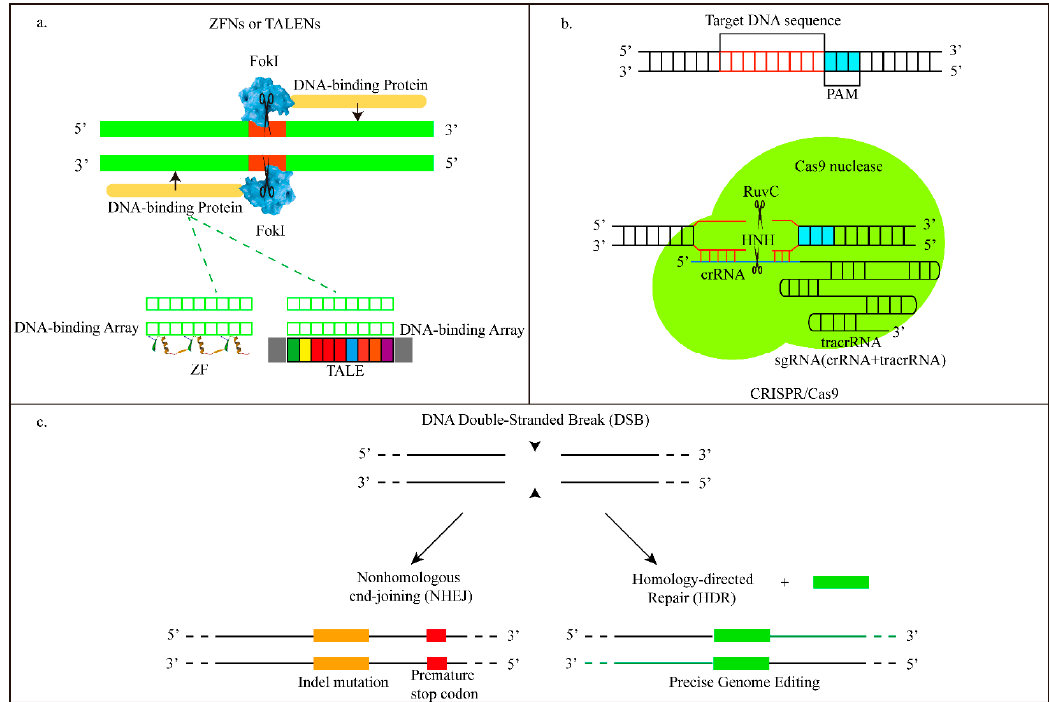
Figure 1. Endogenous DNA repair and three genome editing tools. ( a ) Zinc finger (ZF) and transcription activator-like effector (TALEs) proteins are DNA-binding domains which can be modularly combined to bind targeted sequences. ZF and TALE domains can separately recognize three and one bp of DNA. These site-specific nucleases are the fusion of DNA-binding domains and Fok I endonucleases; ( b ) Cas9 nucleases in the clustered regularly-interspaced short palindromic repeat-associated nuclease Cas9 (CRISPR/Cas9) system target specific DNA sequences with the guide aid of sgRNA, then directly achieve base-pairing with target sequences. The binding of the Proto-spacer adjacent motifs (PAM, blue) downstream of target sites aids to directing Cas9-mediated double-stranded break (DSB); and ( c ) DNA DSBs can be typically repaired via non-homologous end-joining (NHEJ) or homology-directed repair (HDR), from reference [15].